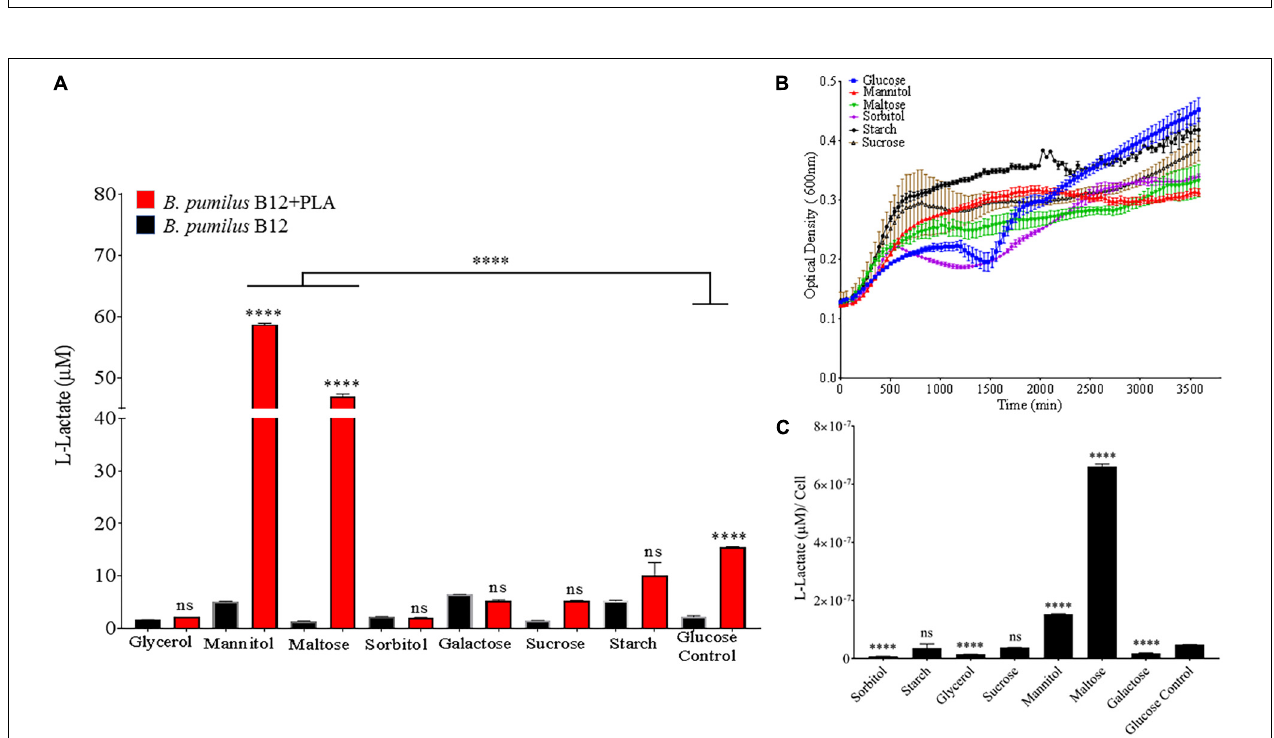
FIGURE 7 | Bacillus pumilus B12 increases alters L-lactate release from PLA when grown in different carbon sources. (A) Initial measurements of B. pumilus B12 grown in different primary carbon sources at a concentration of 55 µ M taken after 48 h. Red bars indicate the addition of PLA, black bars indicate B12 grown in media only. All ∗∗∗∗ and ns above red bars indicates ANOVA ∗∗∗∗ p -value ≤ 0.0001; ns, not significant against media only control. ∗∗∗∗ above the line indicates p -value ≤ 0.0001 against glucose carbon source. These assays were performed with three biological and three technical replicates. (B) Optical density-based growth curves of B. pumilus B12 in the carbon sources taken over 48 h. Each growth curve represents twelve biological replicates. (C) Release of L-lactate from PLA normalized for growth of B. pumilus B12 after 48 h. ANOVA results ∗∗∗∗ p -value ≤ 0.0001 ns, not significant against standard glucose supplementation.